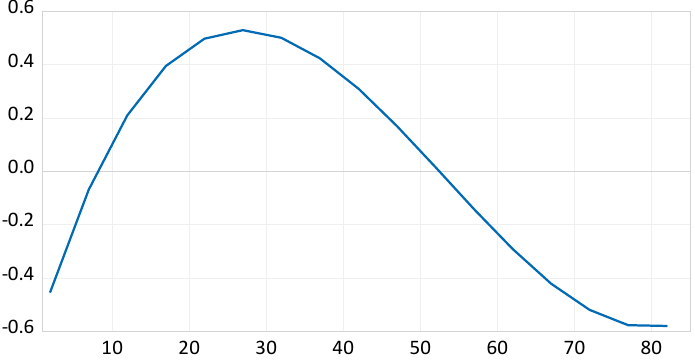
Figure 2. Implied coefficient of age structure: Model (1). Note: x -axis represents the age and y -axis represents the normalized effect.